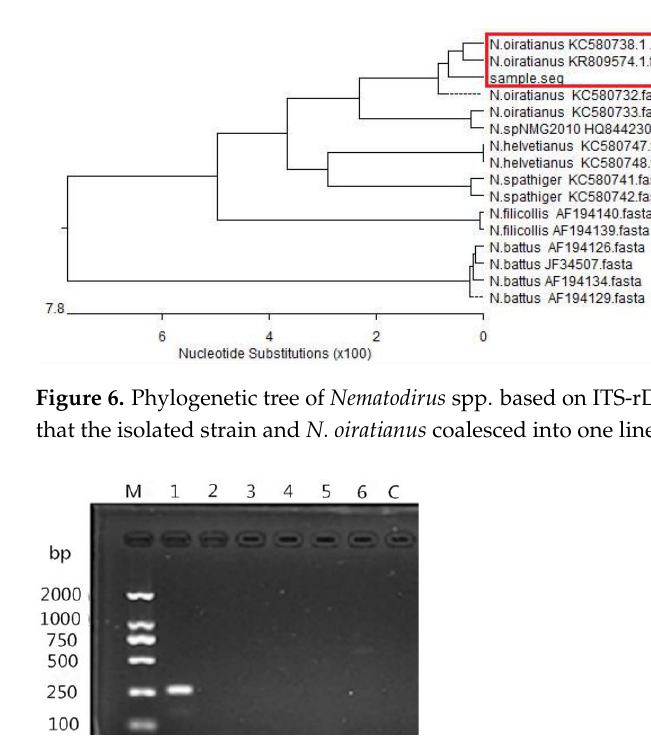
Figure 5. Homology alignment result based on ITS-rDNA sequences. The red box indicates that the isolated strain has high homology with N. oiratianus .